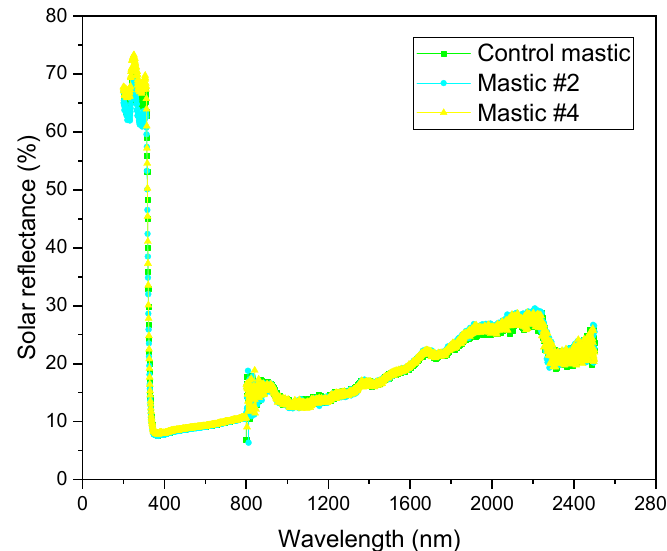
Figure 8. Solar reflectance results of control mastic, mastic #2 and mastic #4.